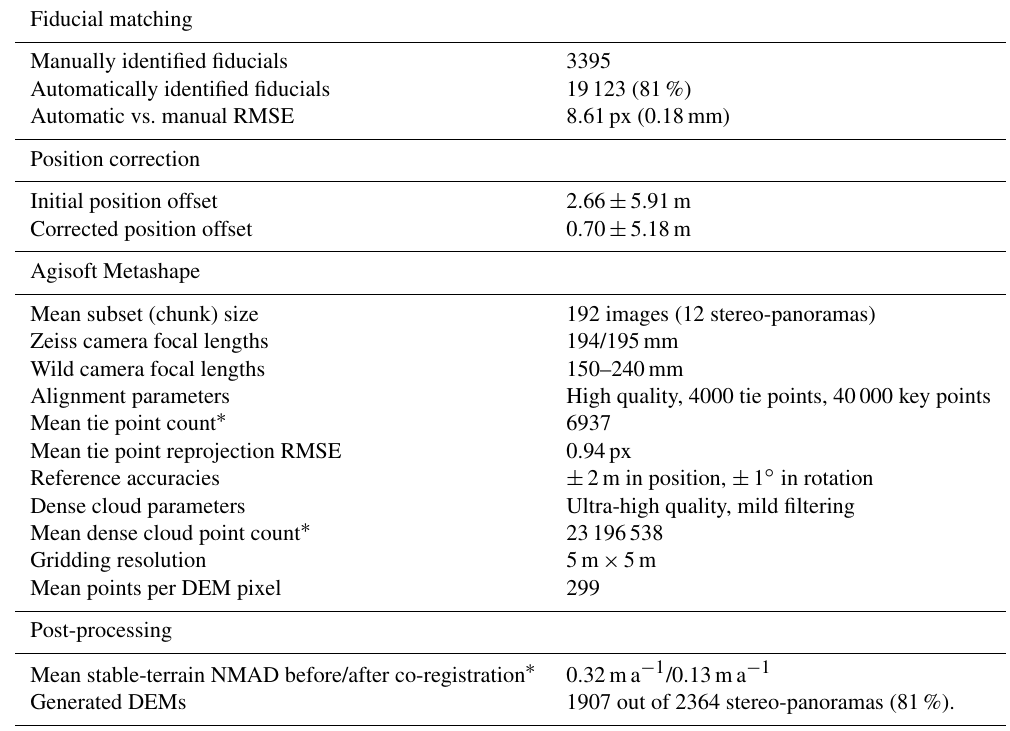
Table 1. Photogrammetric processing parameters. The “high” alignment quality and “ultra-high” dense cloud quality mean using the full image resolution for each respective step. “Mild” (one-third strength) dense cloud filtering is a proprietary Metashape filtering setting. “NMAD” is the normalised median absolute